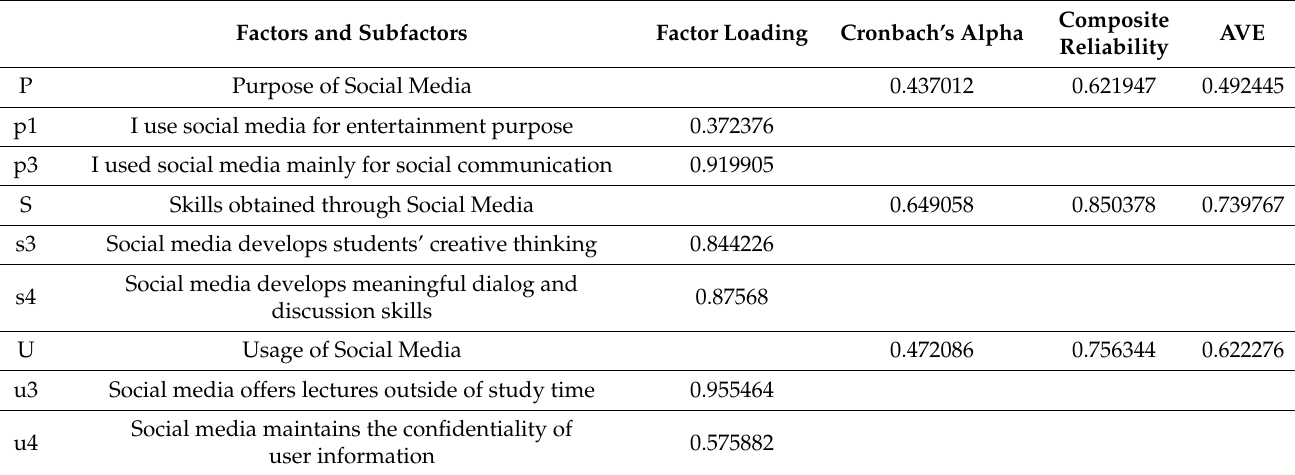
Figure 5. Final path model after removing the least significant variables. Table 4. Indicators of latent constructs